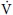
Relationship between the decline in aerobic capacity and progression of emphysema.The mean annual changes in peak V˙
o
2 (ΔpV˙
o
2) were significantly correlated with those in the total LAA scores (ΔLAA) (p<0.0001, r = -0.546).